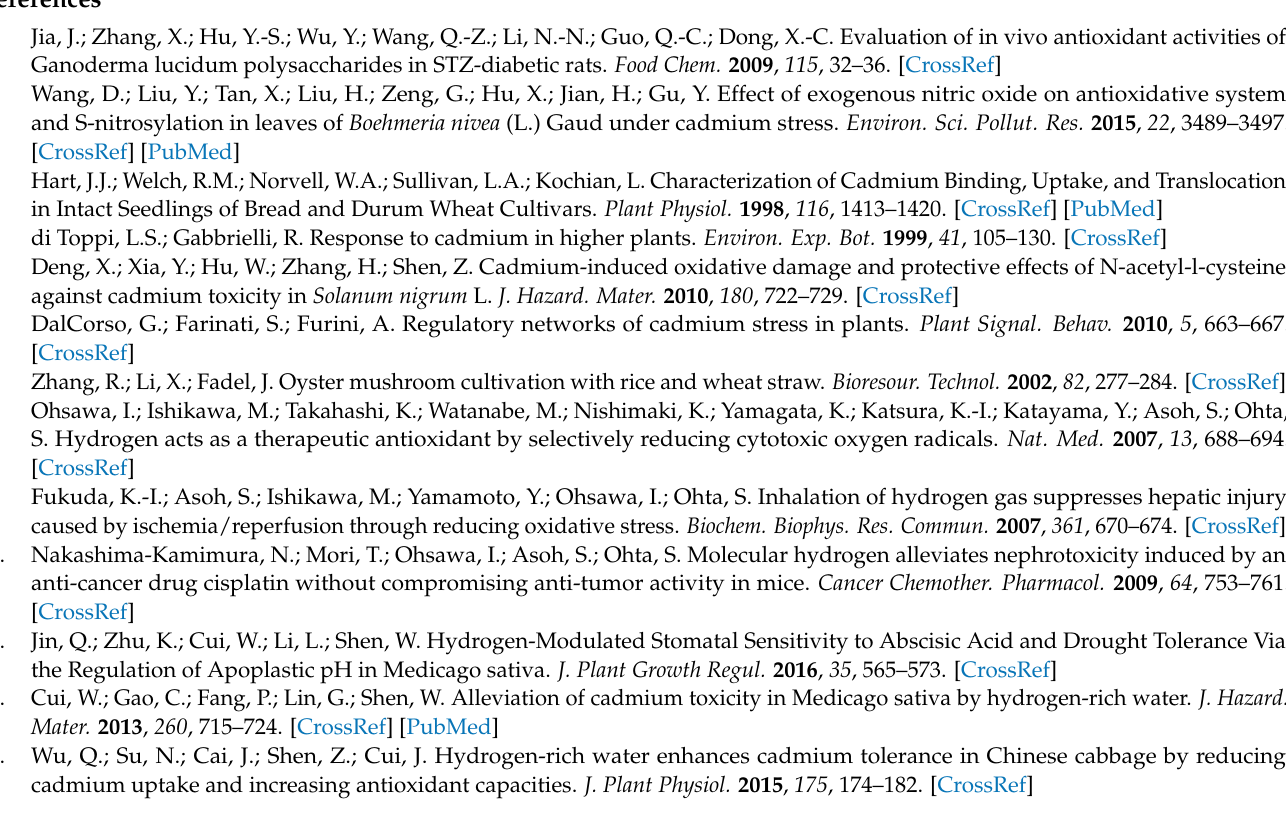
Figure S7: H 2 , HRW, SNP, NO’s scavenger, cPTIO, Na 2 WO 4 or proline had no significant effect on mycelial growth or NO content under normal